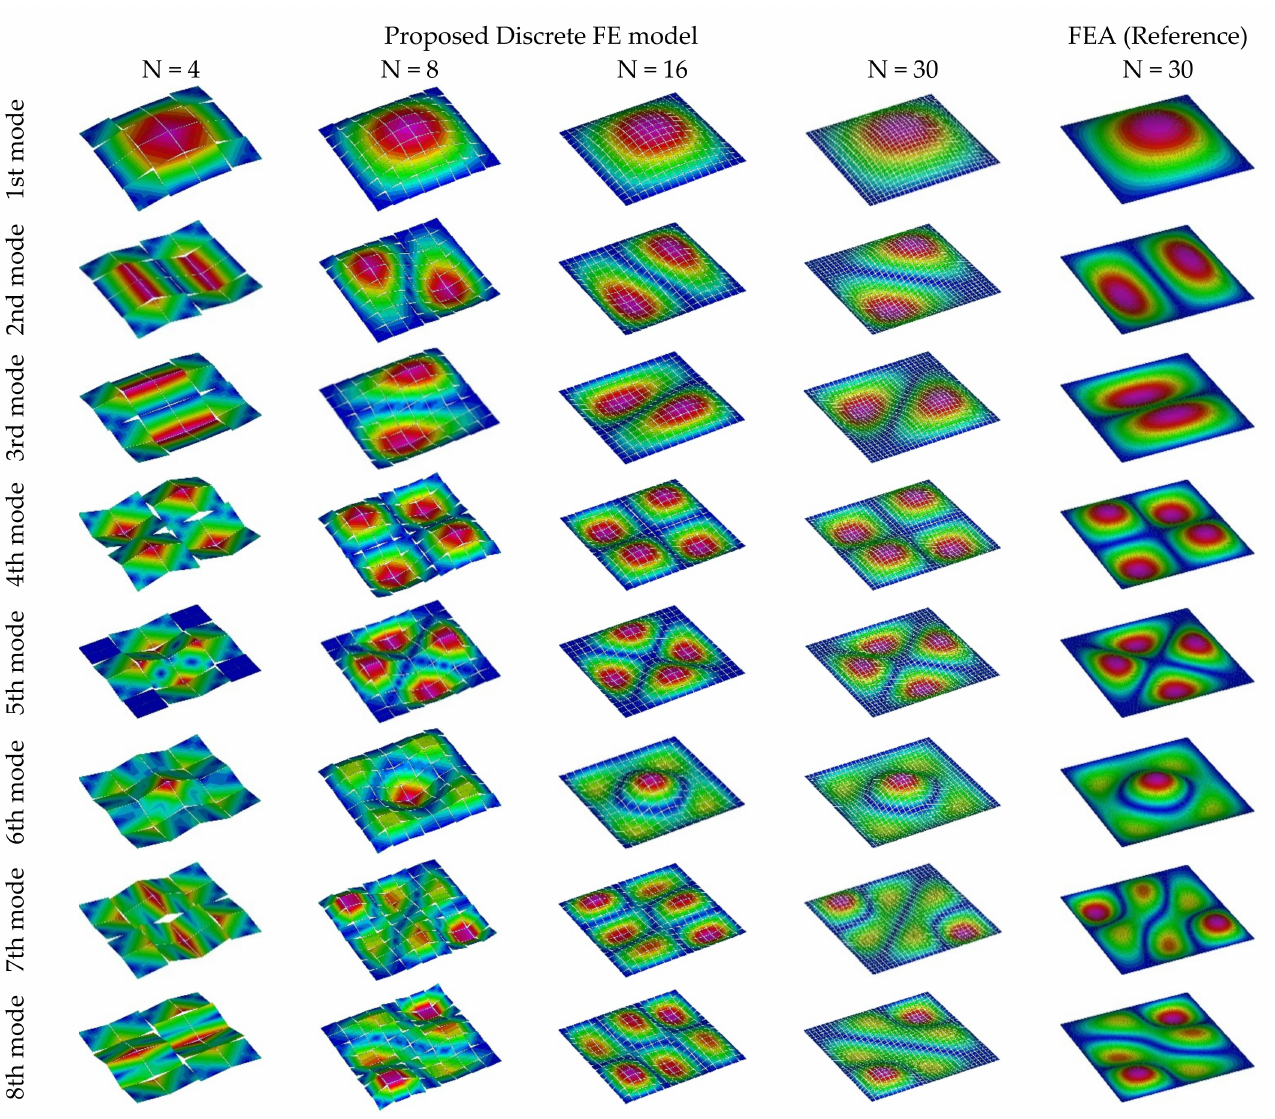
Figure 6. Deformed shape of the first eight eigenmodes obtained with the macro–element (discrete) model and through a classical